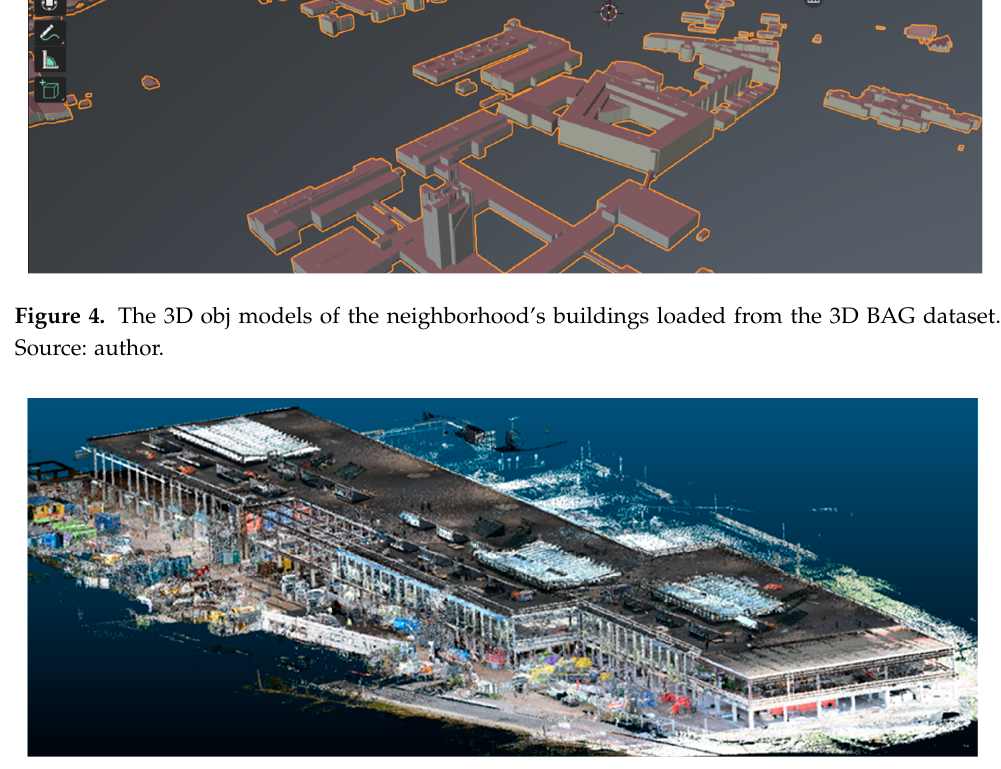
Table 2. The dataset used for each scale of navigation.